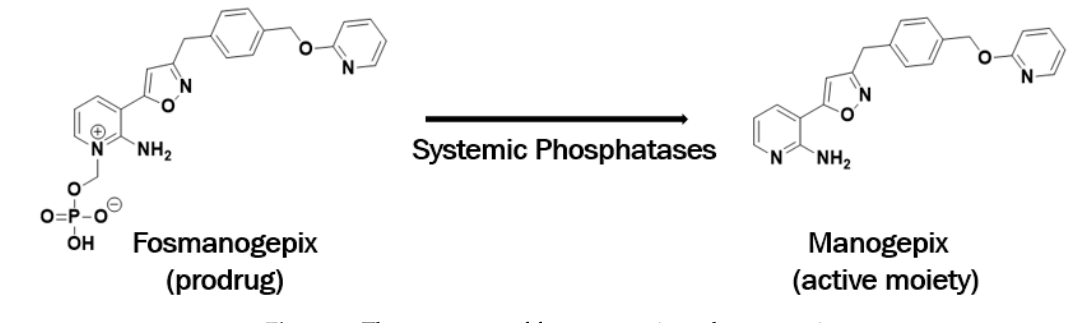
Figure 1. The structures of fosmanogepix and manogepix.